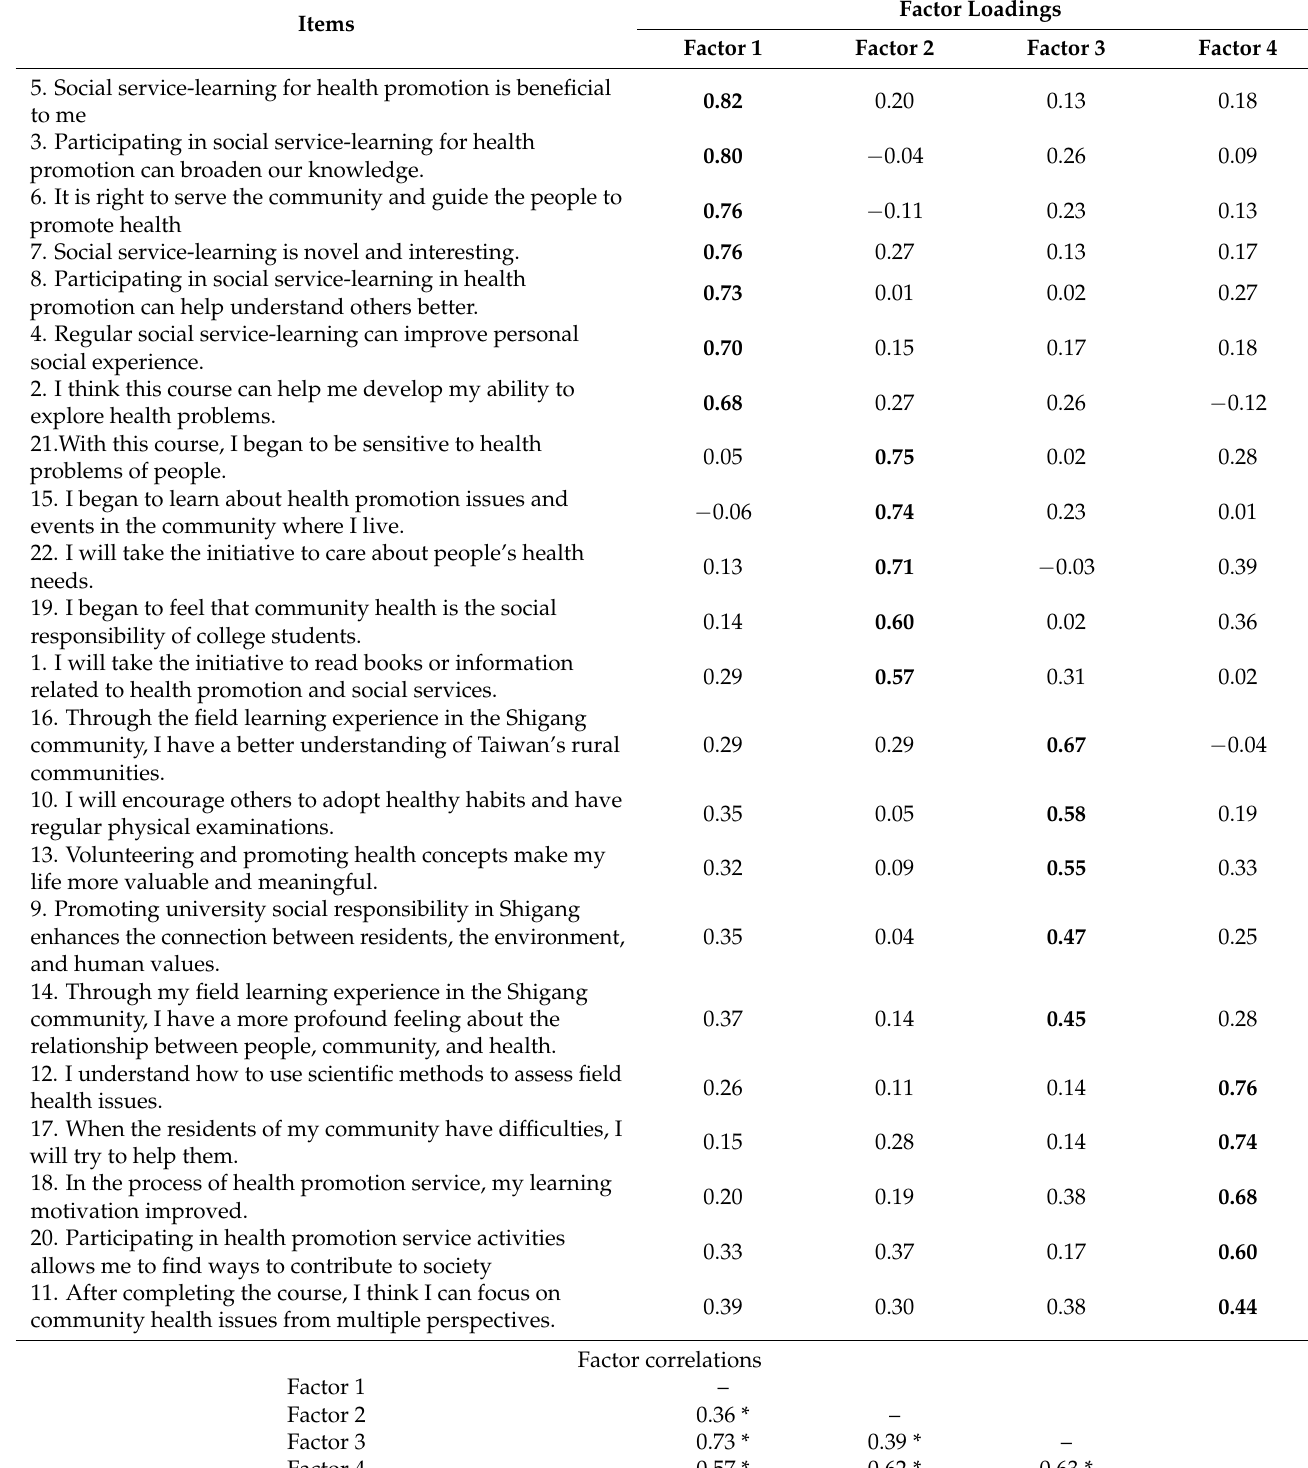
Table 3. Exploratory factor analysis: structure matrix coefficients for the HPLS-USR (N =